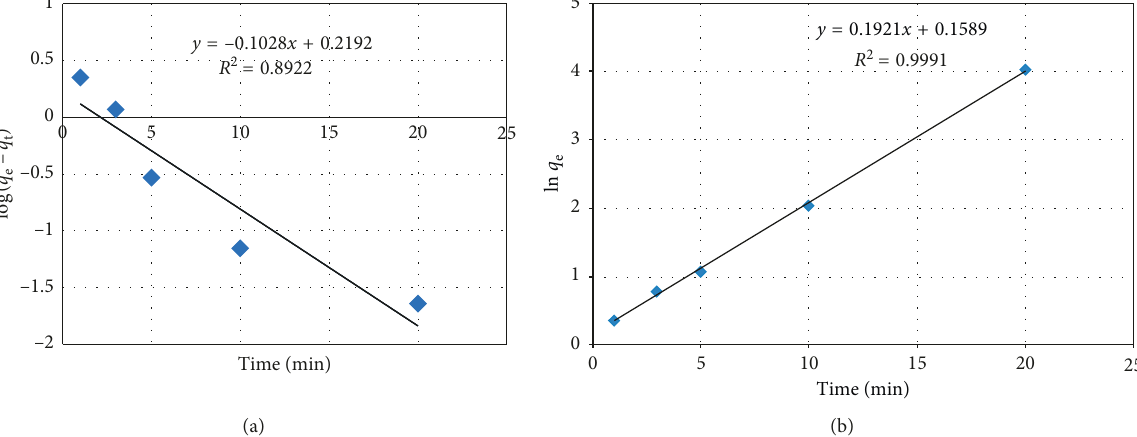
y = –0.1028 x + 0.2192 R 2 = 0.8922